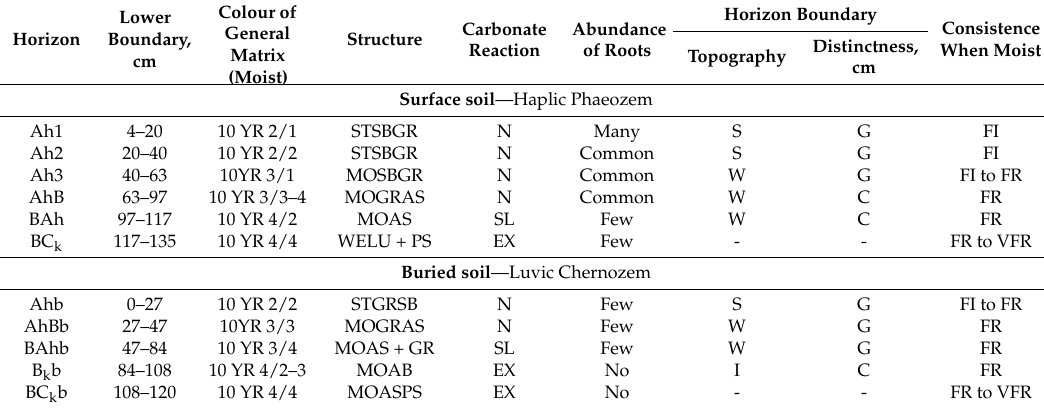
* Legend—see Table